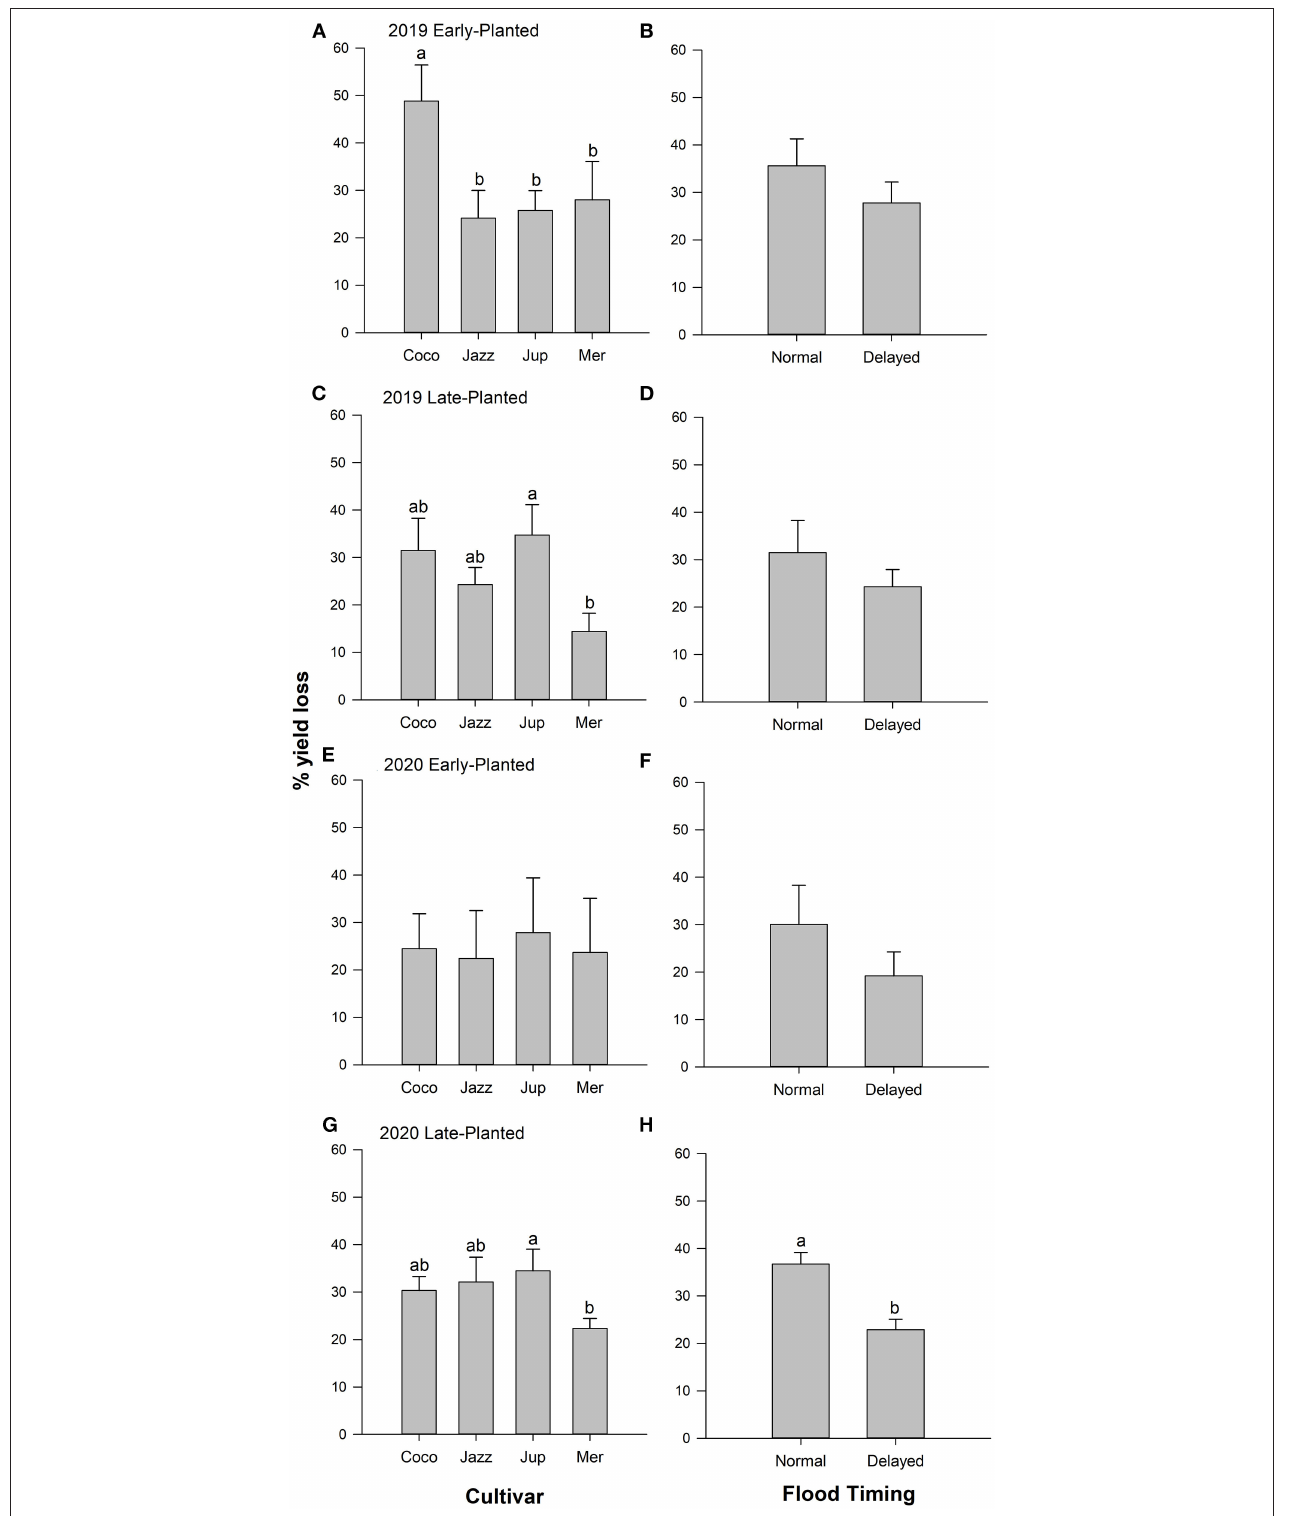
FIGURE 5 | Mean ( + SEM) yield loss as affected by (A,C,E,G) rice cultivar and (B,D,F,H) flood timing main effects, Crowley, Louisiana, 2019–2020. Analyses were conducted separately by year and planting date. Bars accompanied by the same letter do not differ significantly (Tukey’s HSD α > 0.05).